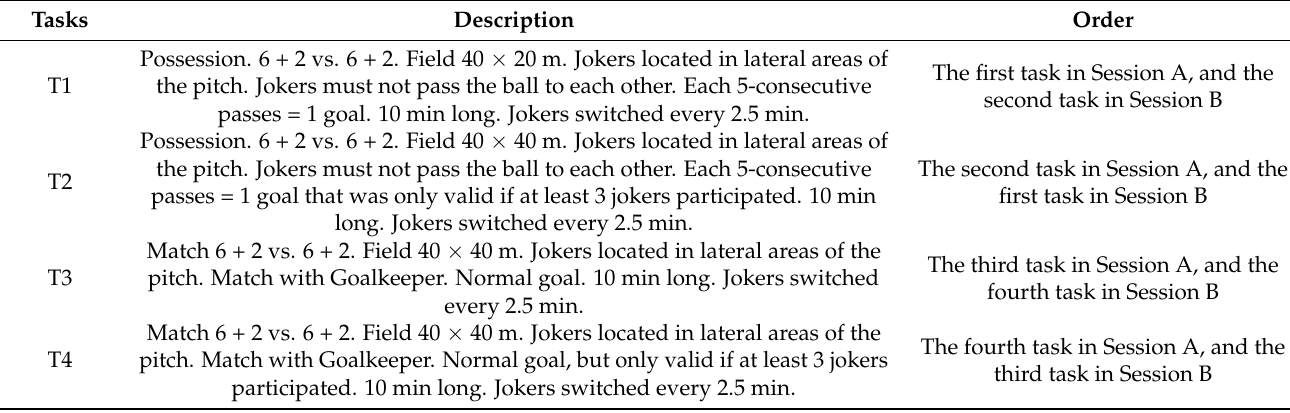
Table 1. Design of the investigation. Task description and order. Tasks Description